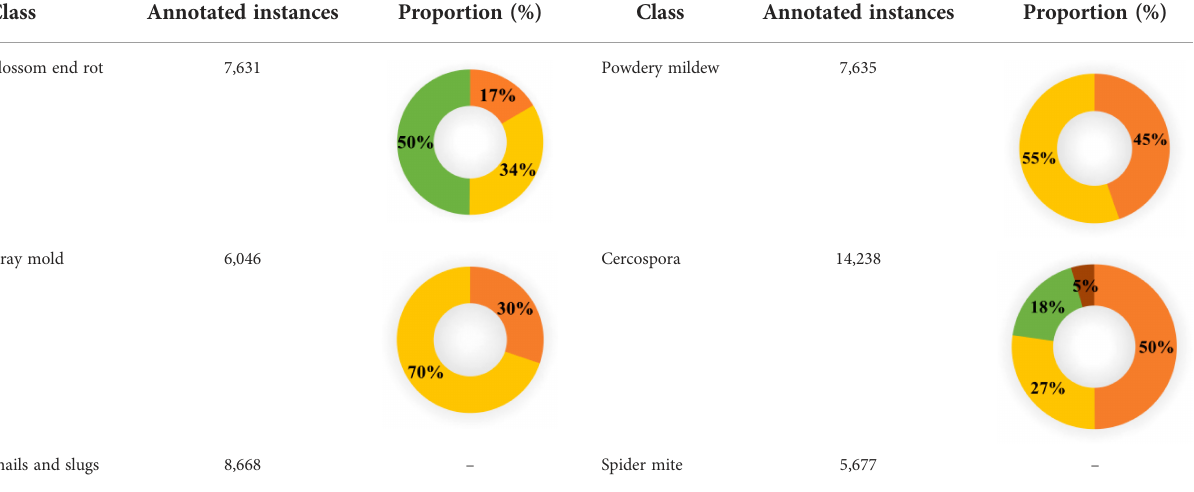
TABLE 2 Statistical distribution of the paprika plant disease